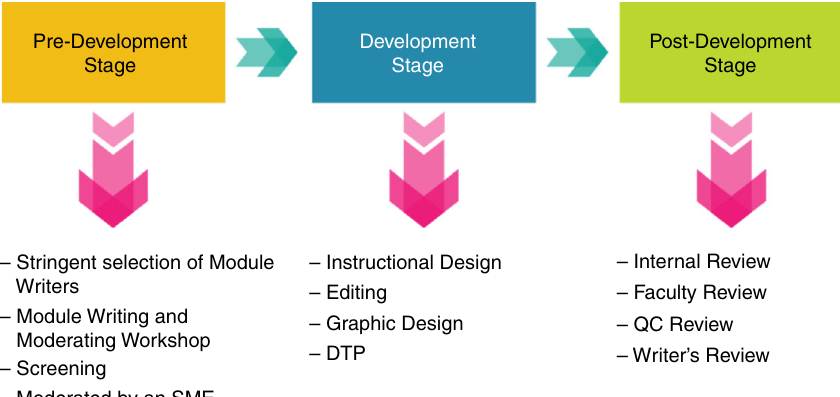
Figure 1. QA process for print module development in